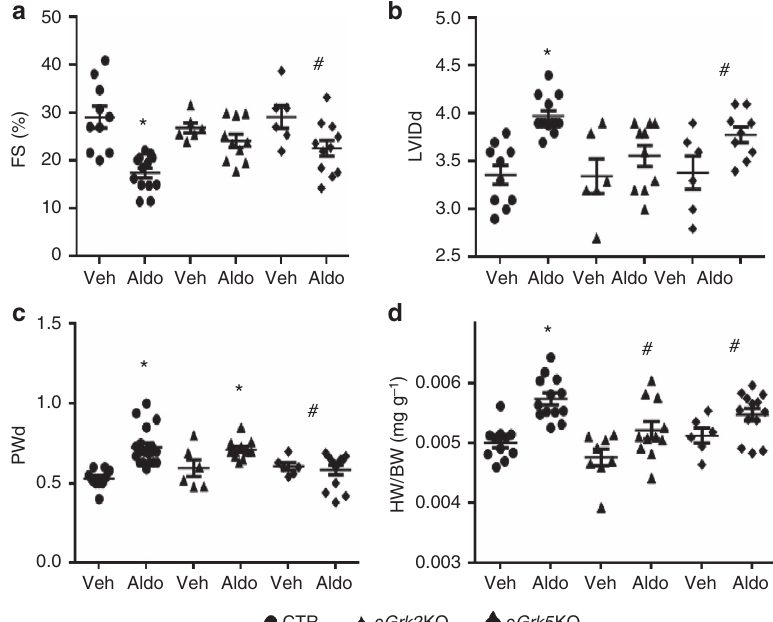
Figure 7 | Aldosterone negatively affects in vivo cardiac function in a GRK2- and GRK5-dependent manner. ( a – c ) Dot plots showing the echocardiographic analysis of individual mice from WT (CTR), cardiac Grk2 and Grk5 knockout (c Grk2 KO and c Grk5 KO) mice after 4 weeks of Aldo (2 m g per day) or Veh (saline) treatment. Shown are measurements for ( a ) fractional shortening (FS, %); ( b ) LV internal diameter at diastole (LVIDd); and ( c ) posterior wall diastolic thickness (PWd); * P o 0.05 versus CTR Veh; # P o 0.05 versus CTR Aldo. ( d ) Ratio of heart weight to body weight (HW/BW) following Aldo infusion in these mice for 4 weeks; * P o 0.05 versus CTR Veh; # P o 0.05 versus CTR Aldo. ( a – d ) Statistical significance between groups was determined by one-way ANOVA with Bonferroni post hoc correction. All data are shown as mean ± s.e.m. CTR,